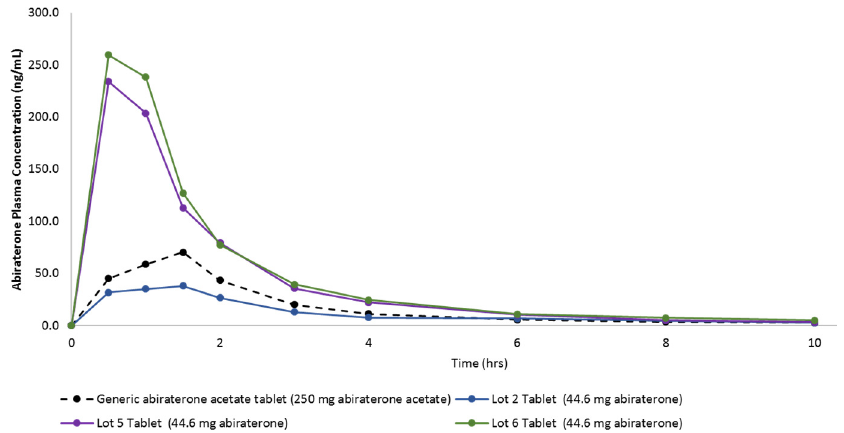
Figure 9. In vivo plasma concentration versus time profiles from oral dosing of the generic abiraterone acetate tablet, the Lot 2 Tablet, the Lot 5 Tablet, and the Lot 6 Tablet in fasted non-naïve male beagle dogs.